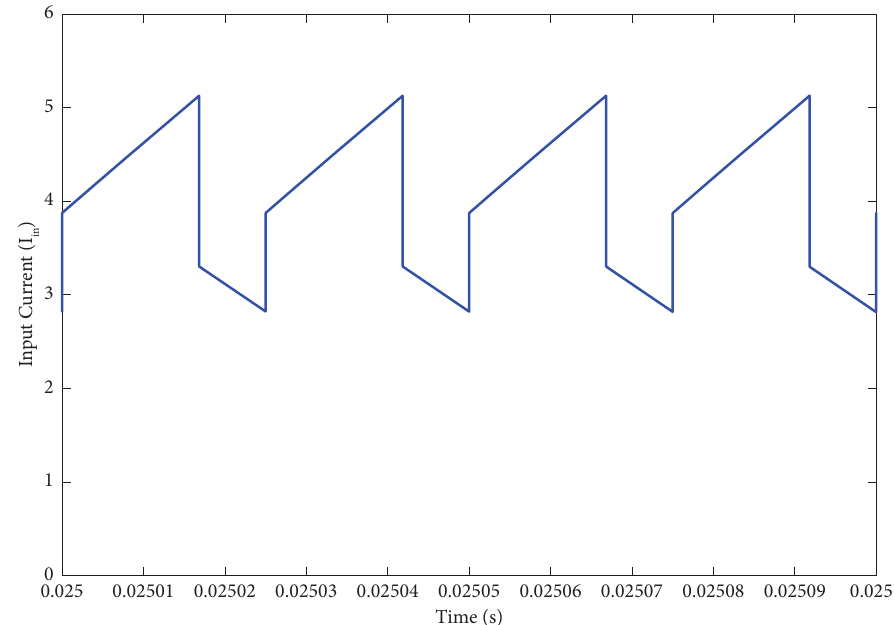
Figure 6: Simulation waveform of input current ( I